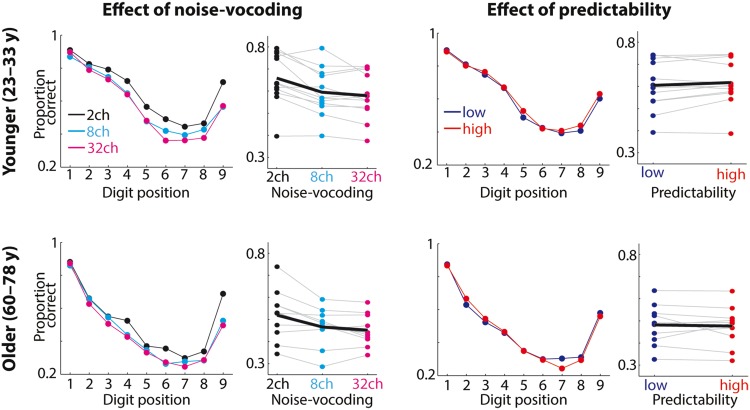
Behavioral results. Average proportions of correctly recalled digits for younger (top row) and older participants (bottom row) as a function of acoustic detail of task-irrelevant speech (noise-vocoding with 2, 8, or 32 channels; left) and predictability of sentence endings (low vs. high; right). Gray lines and colored dots on the right of each of the 4 subpanels show the proportions of correctly recalled digits for individual participants averaged across all (9) digit positions; the black line indicates the average across participants. The proportion of correct responses decreased with higher numbers of channels used for noise-vocoding of the task-irrelevant speech but was unaffected by the predictability of sentence endings.